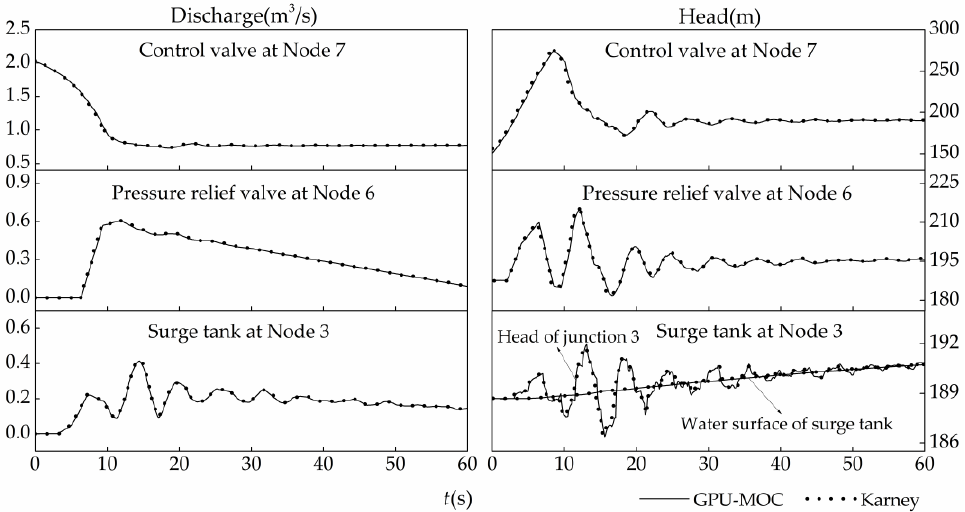
Figure 5. Comparison of head and discharge at surge tank (Node 3), pressure relief valve (Node 6), and control valve (Node 7) with data from Karney [26].